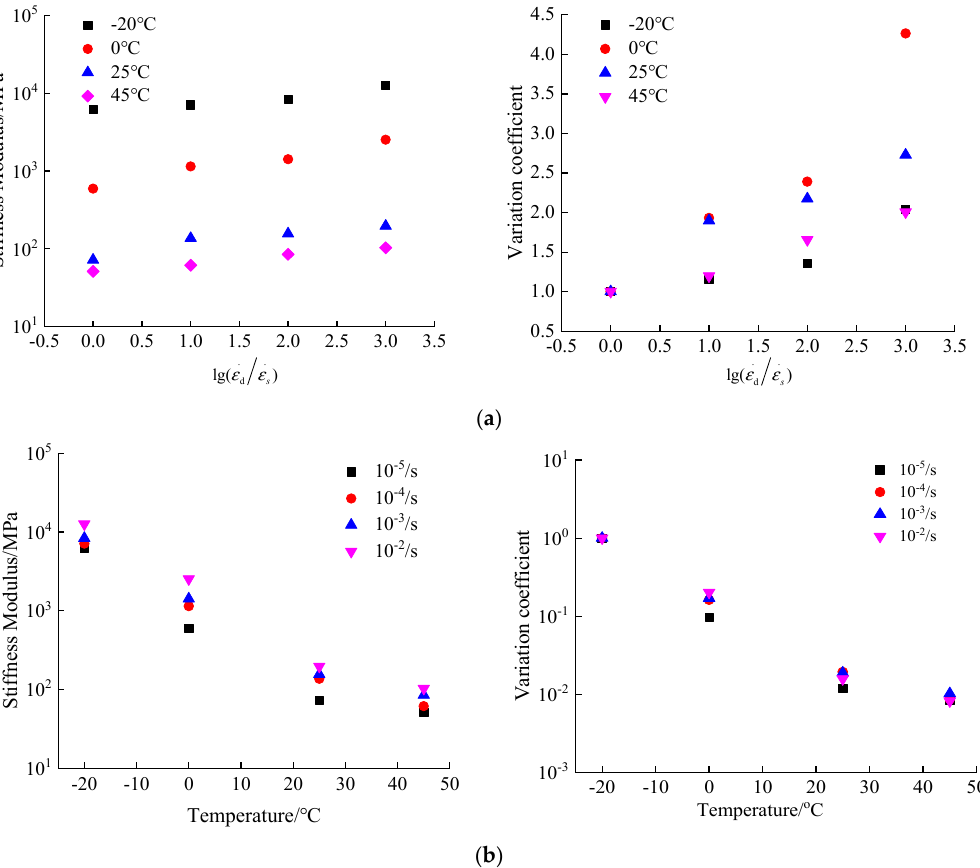
Figure 9. Temperature effect and strain rate effect on the compressive stiffness modulus. ( a ) strain rate effect; ( b ) temperature effect.